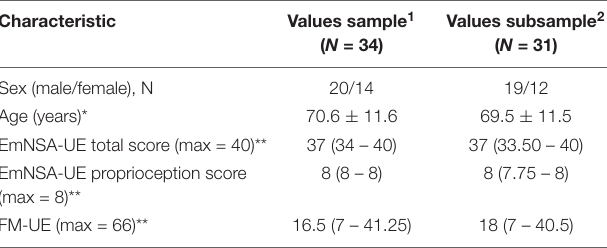
TABLE 1 | Baseline characteristics of patients included in the